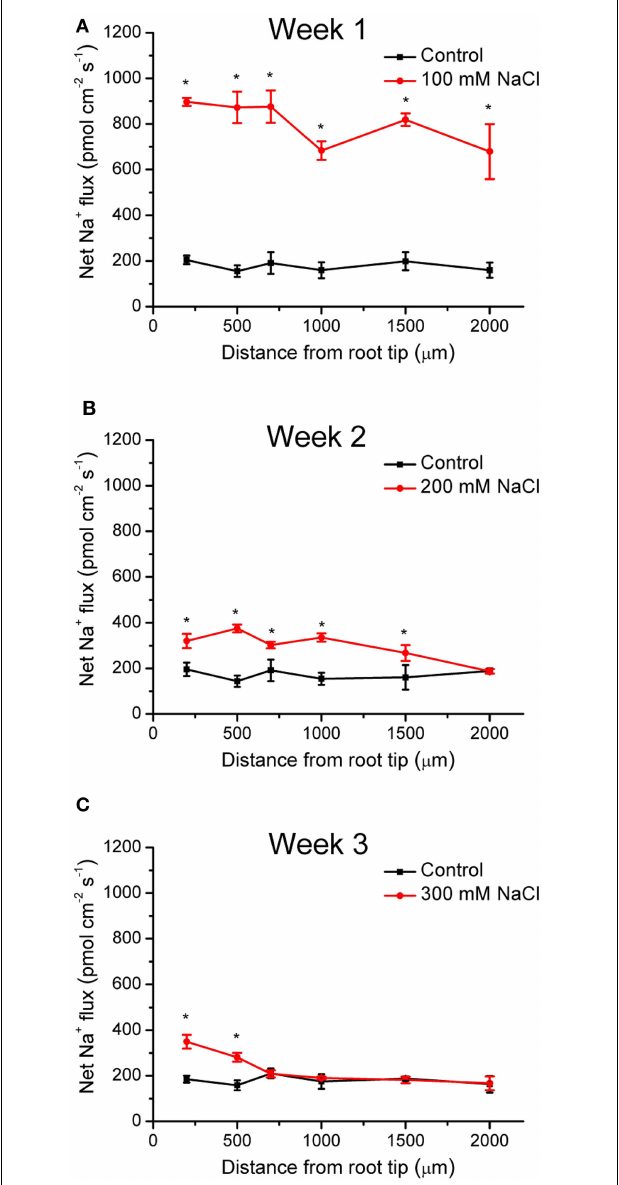
FIGURE 1 | Effects of NaCl on net Na + fluxes in young roots of K. candel . Plants were treated by a rising NaCl concentration from 100 to 300mM weekly for 3 weeks. The control was not exposed to NaCl. Steady Na + flux profiles on week 1 (A) , week 2 (B) , and week 3 (C) were determined along root axis at apical zones, 200–2000 μ m from the tip. Each point is the mean of 4–6 replicates. Bars represent standard error of the mean. ∗ P < 0 . 05, control and NaCl